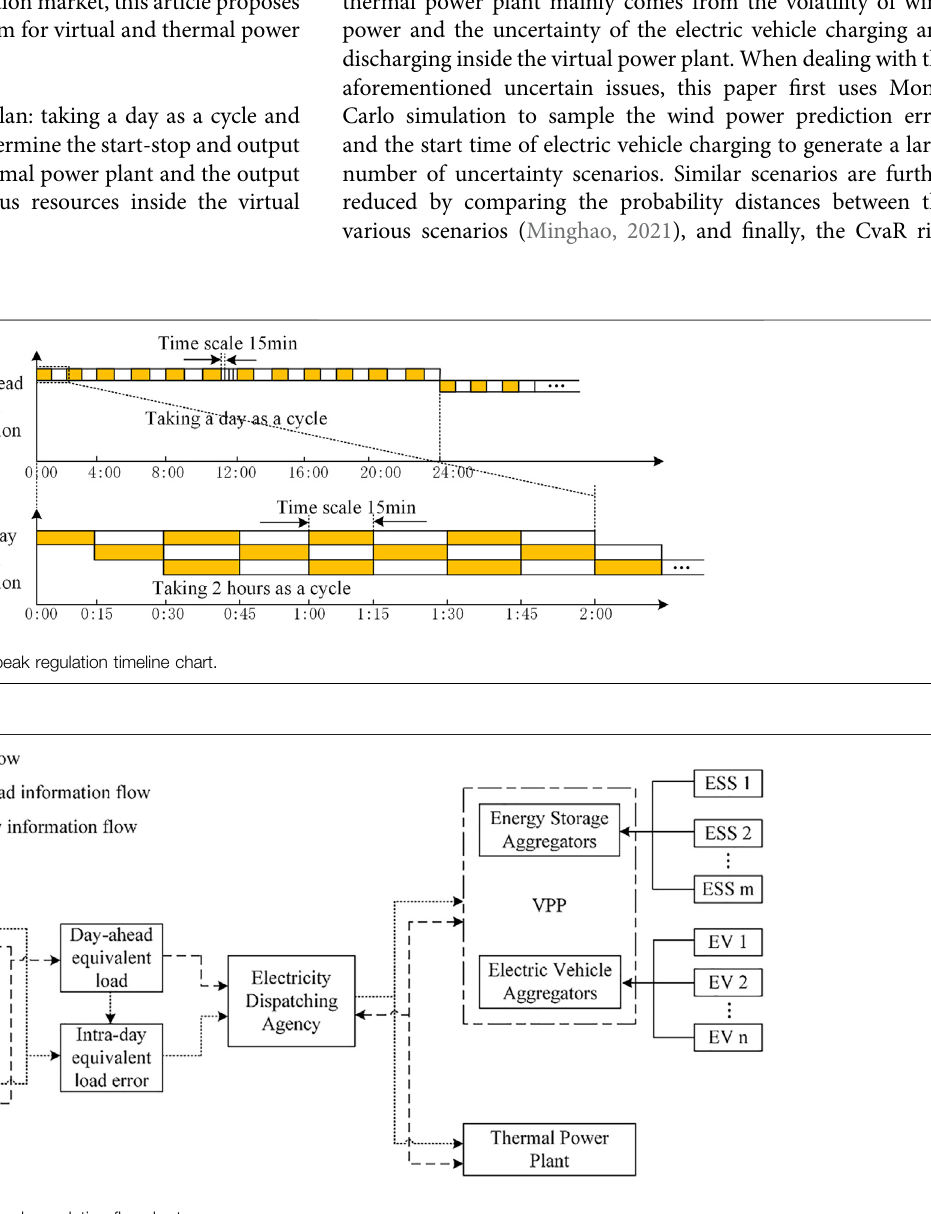
FIGURE 2 | Day-ahead and intra-day peak regulation fl